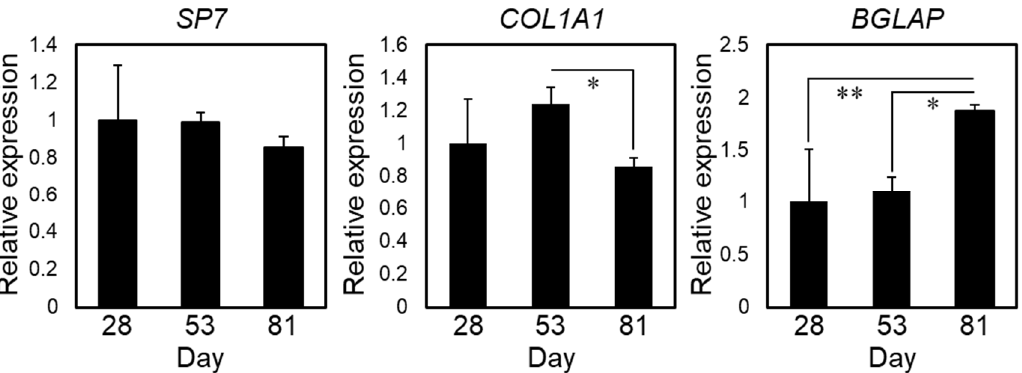
Figure 2. Expression of the osteoblastic markers SP7 , COL1A1 , and BGLAP over time. The data obtained from four biological replicates were averaged and are shown as the mean ± standard deviations (SDs). ** p < 0.01; * p < 0.05. Day counting started from the first day of hiPSC culture, as shown in Figure 1.